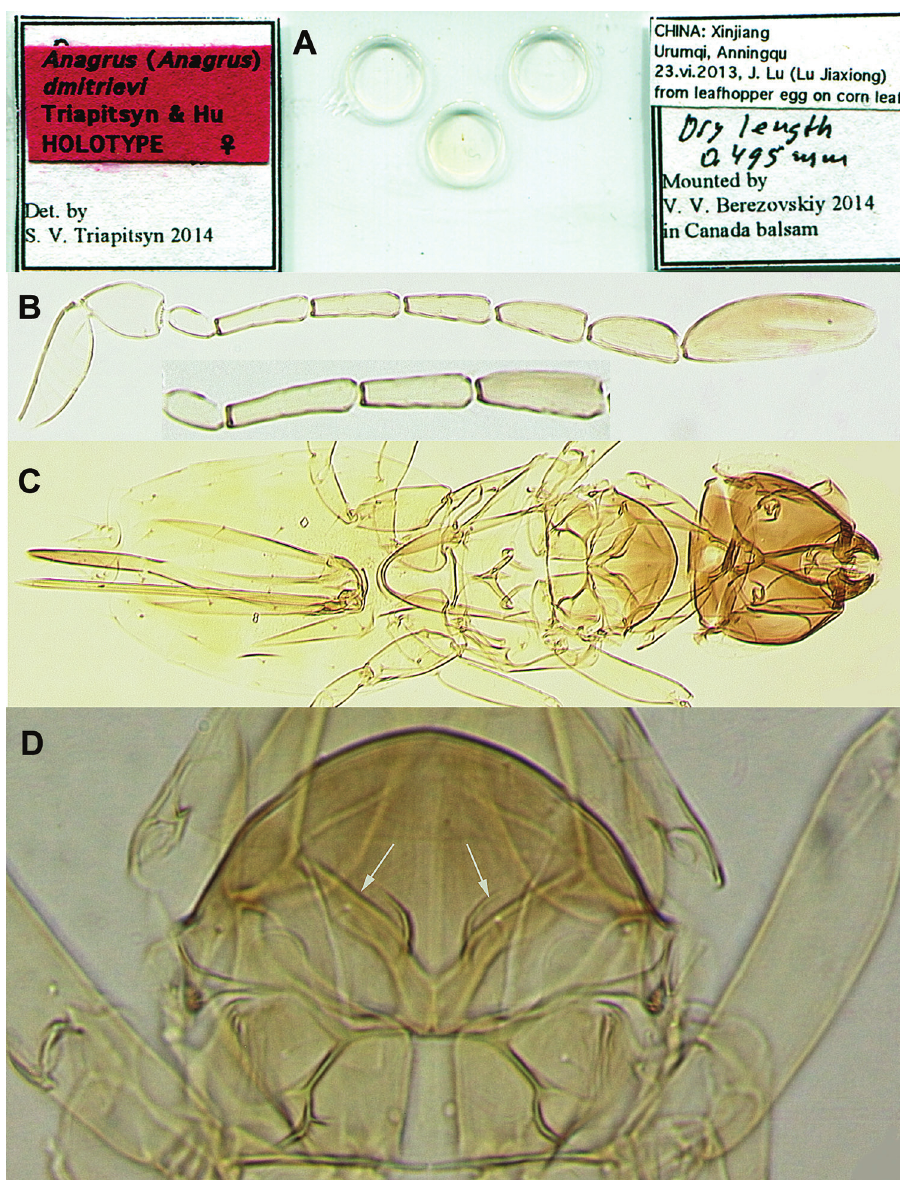
Figure 1. Anagrus dmitrievi (female, holotype): A slide B antennae (complete antenna without mps on F4; F4 of the incomplete antenna with 1 mps) C body D mesoscutum (arrows pointing to adnotaular setae on its